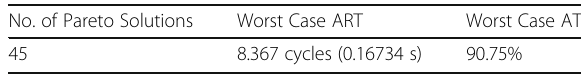
Table 3 Testing